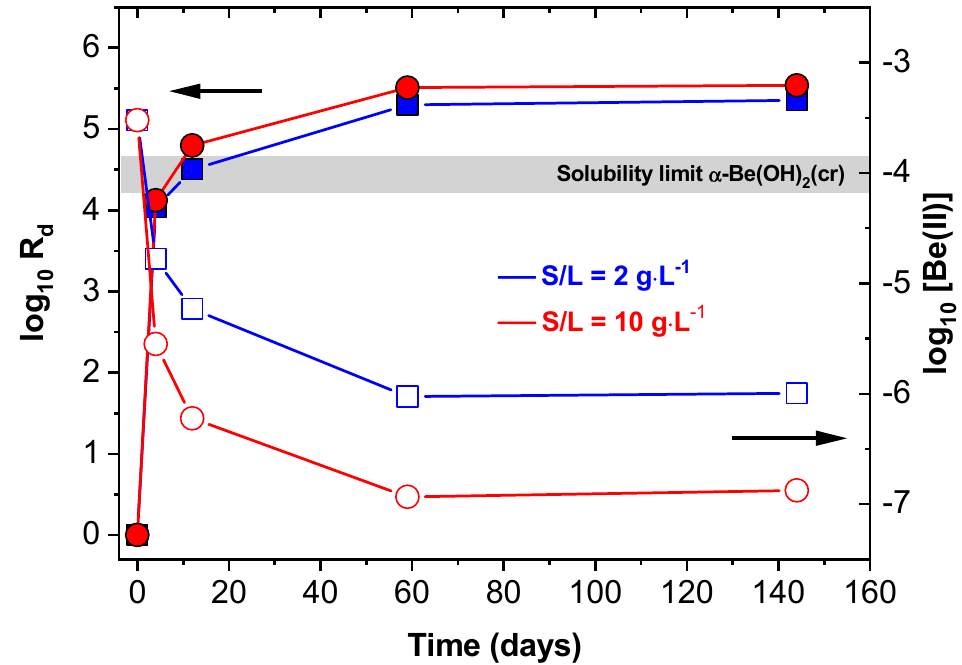
Figure 2. Kinetics of the Be(II) uptake by HCP in degradation stage I with [Be] 0 = 3 × 10 − 4 and S/L = 2 and 10 g · L − 1 . Sorption kinetics expressed in terms of log R d values (left Y -axis, with R d expressed in L · kg − 1 ) and Be(II) concentrations (right Y -axis) as a function of time. Grey region defines the solubility limit of α -Be(OH) 2 (cr) in ACW.